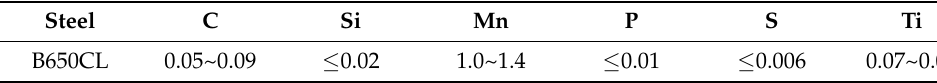
Table 1. Chemical compositions of test material w/%.